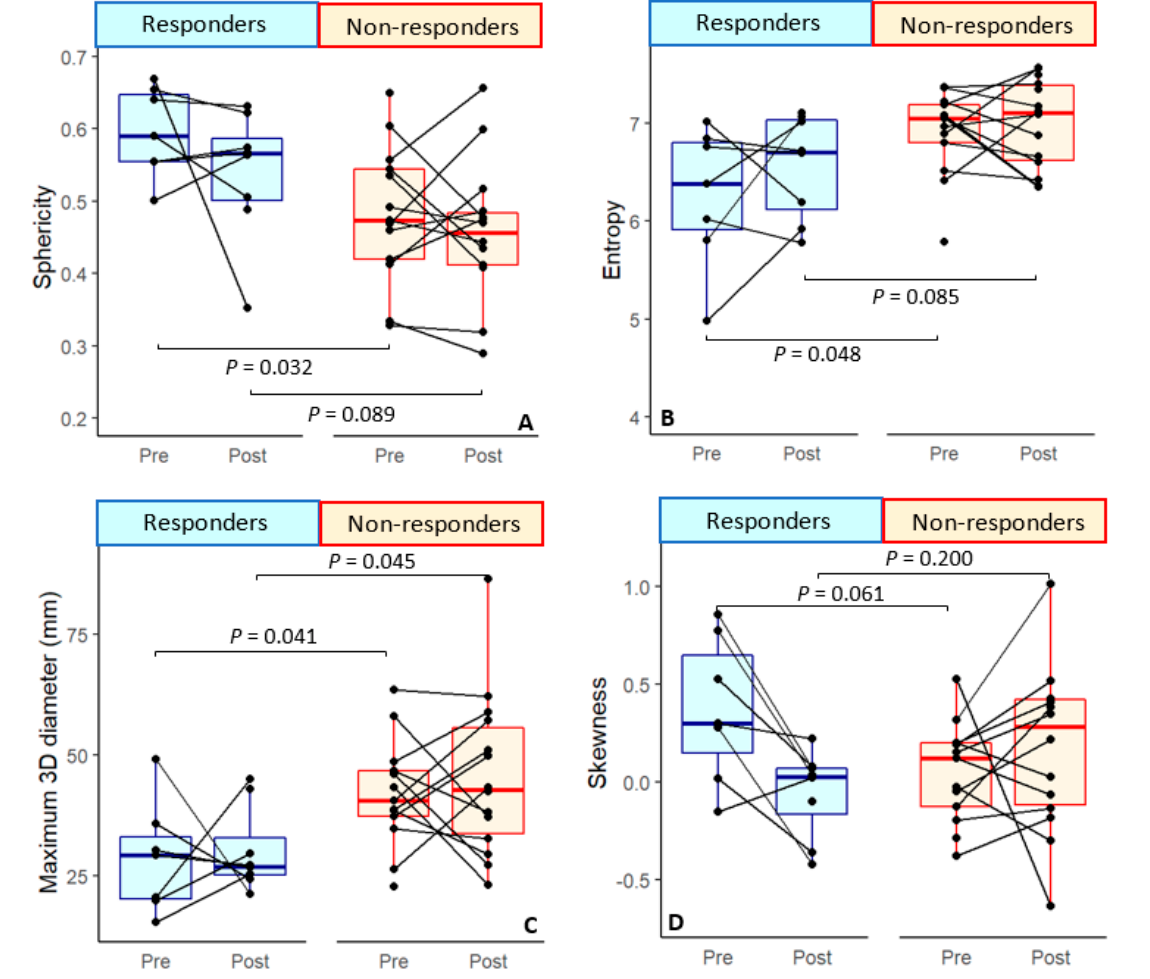
Figure 3. Boxplot overview of some correlations between responder and non-responder groups. ( A ) Sphericity or tumor roundness is significantly higher for responders at pre-treatment; this dissipates at post-treatment imaging. ( B ) Significantly lower levels of entropy can be seen for responders compared to non-responders, but only at pre-treatment imaging. ( C ) The maximum diameter measured using 3D dimensions is significantly lower at pre-treatment imaging for responders compared to non-responders. ( D ) No significance of ADC skewness can be seen between the two response groups at pre- or post-treatment. A near-significant result ( p = 0.066) is observed for the delta of ADC